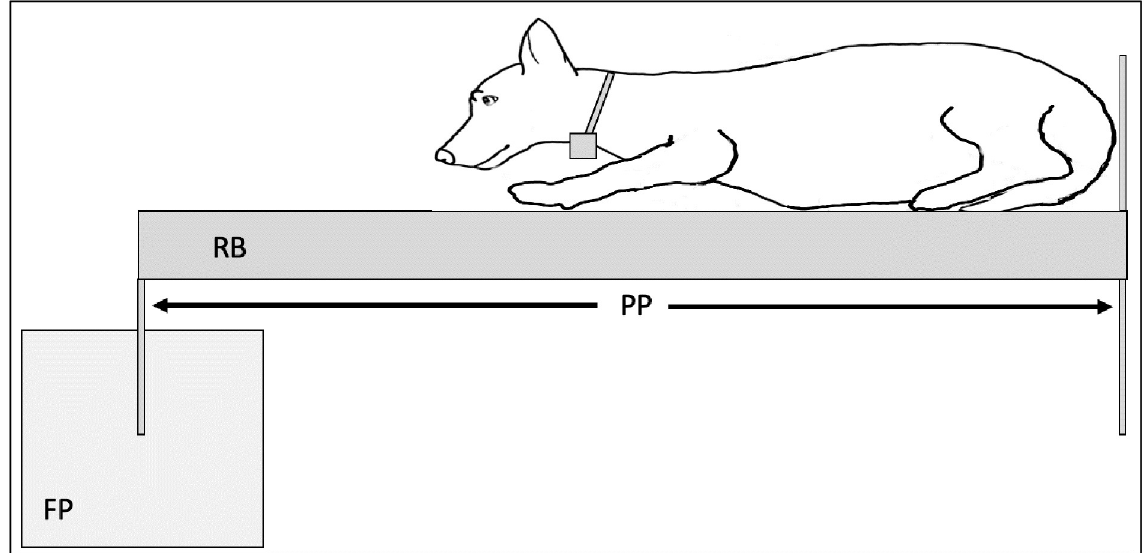
Fig 2. Illustration of a dog positioned on the reaction board (RB) for the measurement of center of mass in the dog’s transverse plane. The dog’s ischium is in contact with the back of the reaction board and the pivot points (PP) are in contact with the floor and force platform (FP).